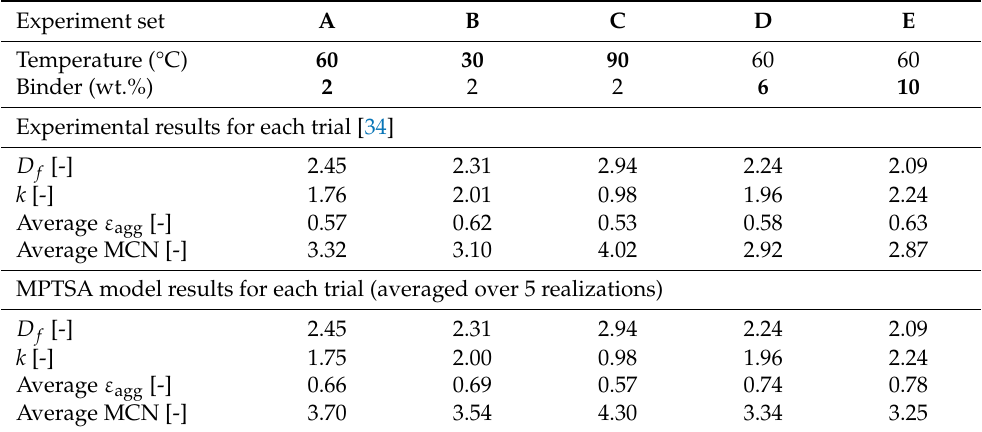
Table 1. Morphological descriptors evaluated using the MPTSA model for different